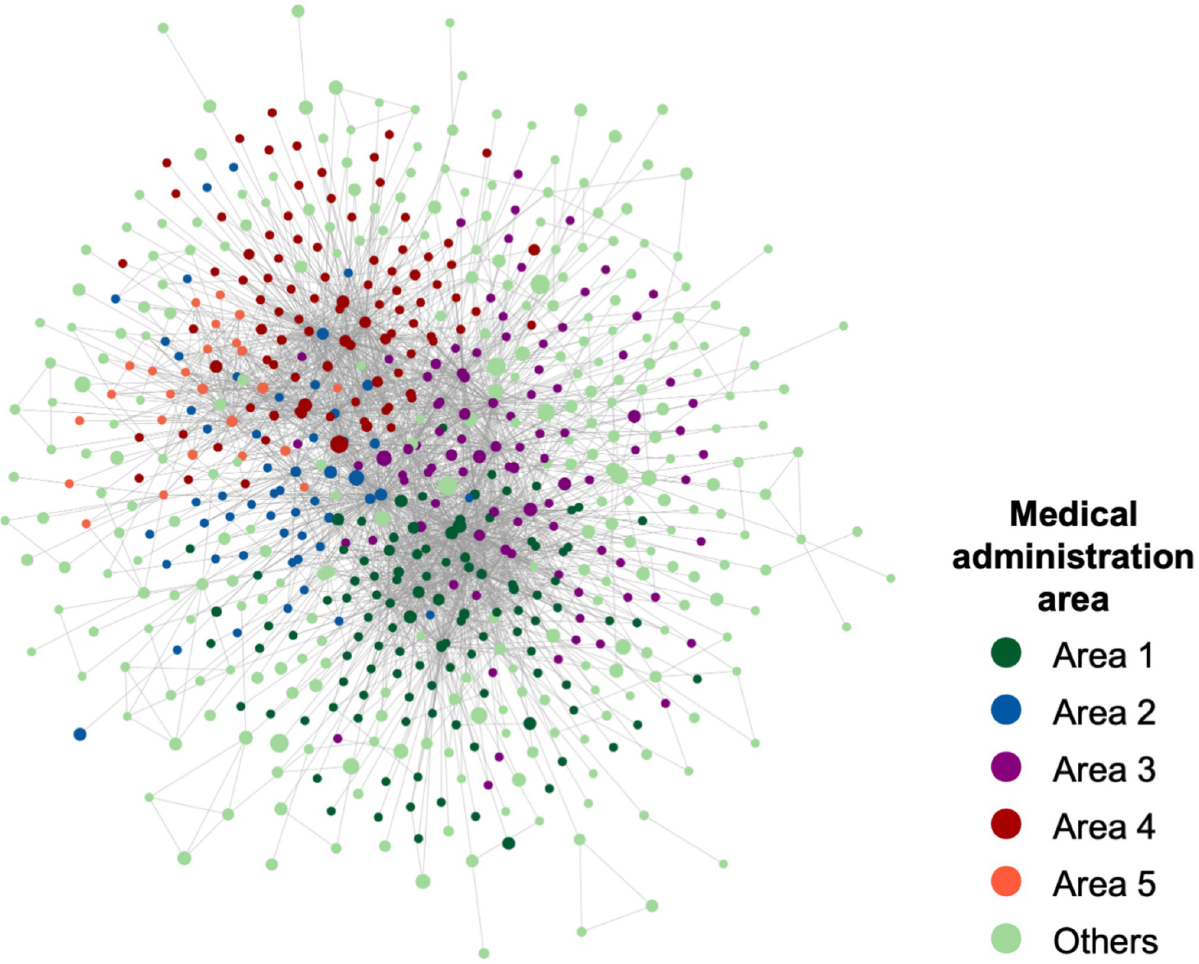
Fig 3. Network diagram of the medical provider network. Number of nodes (medical providers) N = 644, number of edges L = 2756. The prefecture is divided into five medical administration areas, and the nodes are color-coded according to each area. The node size is based on the number of beds in the medical provider. The nodes located in the same area are close to each other on the network.